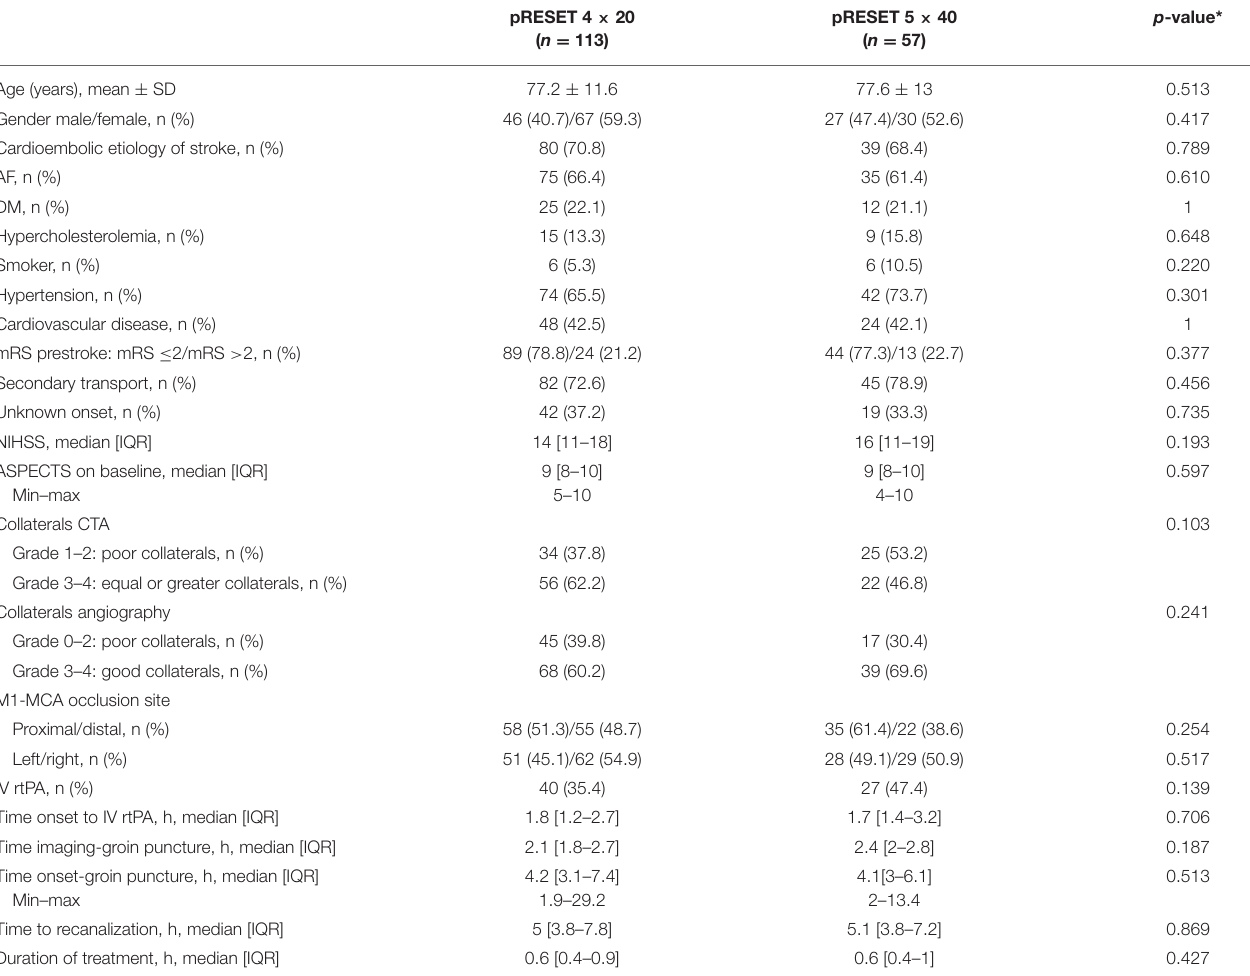
TABLE 1 | pRESET 5 × 40 vs. pRESET 4 × 20 in M1-MCA occlusions: baseline